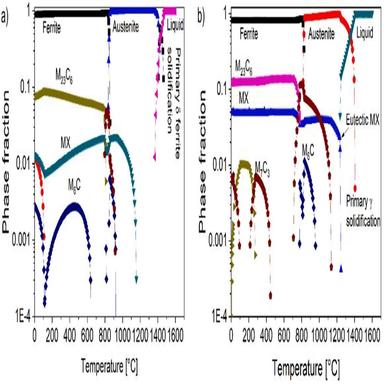
(a) Equilibrium phase evolution for H13 powder particle. (b) Equilibrium phase evolution for the liquid channel with the composition of liquid channel estimated from CALPHAD model.